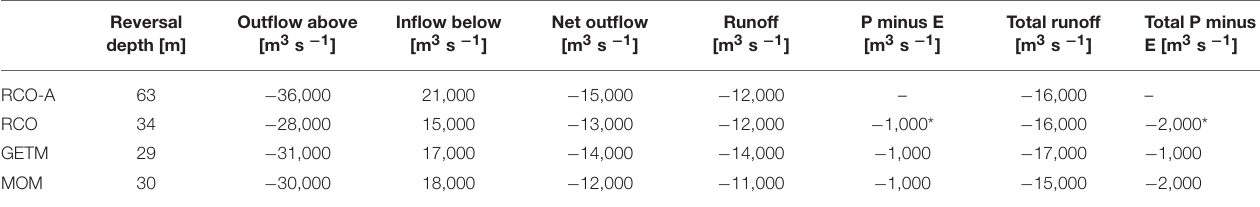
Numbers in the last two columns relate to the entire Baltic Sea including the Kattegat. ( * according to Meier and Döscher, 2002. For RCO-A P minus E is not available).